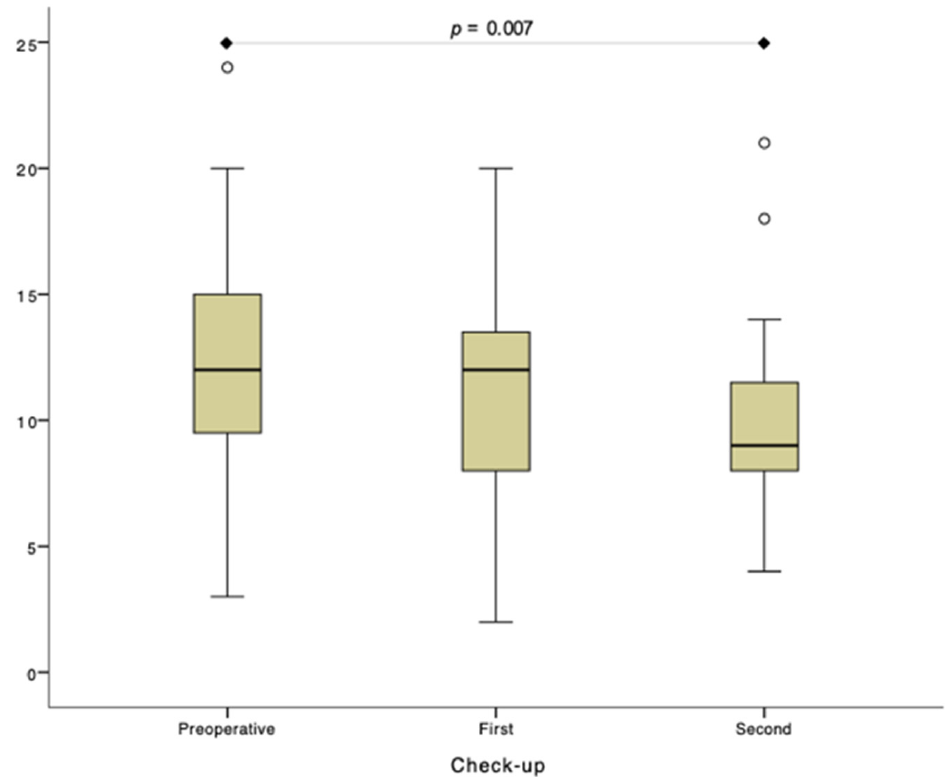
Figure 2. The total score of blood vessel morphology analysis (NBI total ) within the test side. First check-up was performed 1 month and second check-up 6 months postoperatively.